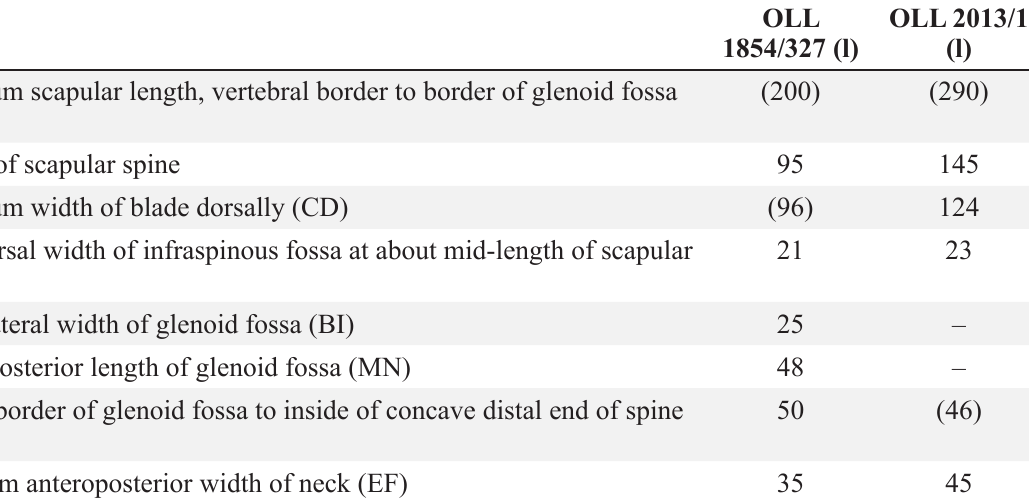
Table 5. Dimensions (in mm) of the scapula of Lentiarenium cristolii (Fitzinger, 1842). Letters in parentheses denote the standard dimensions established by Domning (1978: fig. 7, table 16). Measurements in parentheses indicate preserved lengths.